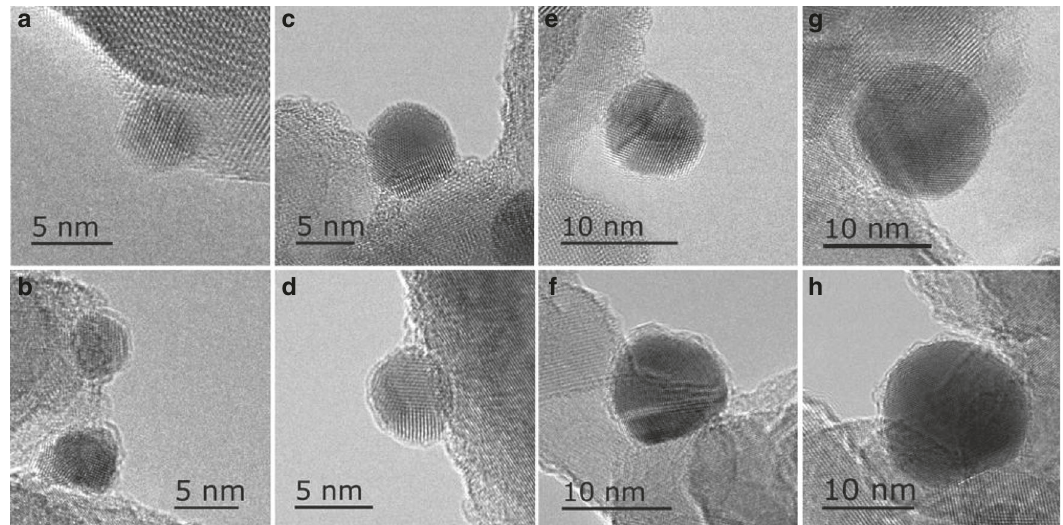
Fig. 2 Representative HRTEM images of different samples. a Au-3 nm, b Au-3 nm-H600, c Au-7 nm, d Au-7 nm-H500, e Au-9 nm, f Au-9 nm-H400, g Au-13 nm, and h Au-13 nm-H400.